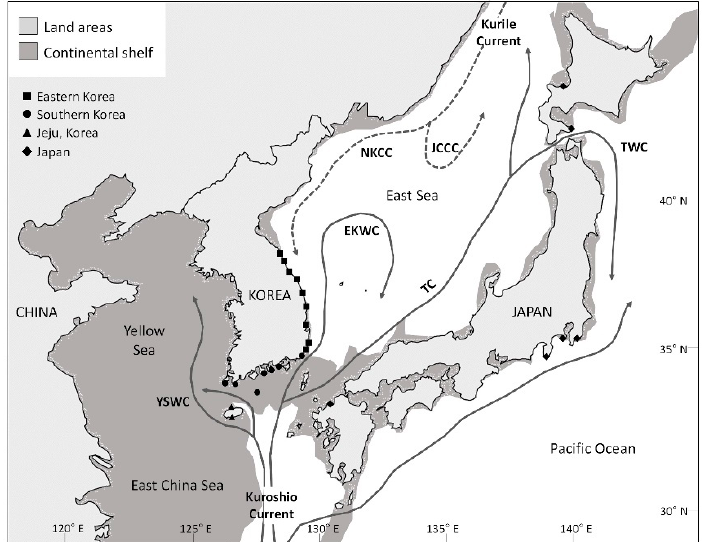
Figure 1. Map of the Korean Peninsula displaying the currents and collection sites of two Pachy- meniopsis species. Shaded areas indicate sea regions that would have been exposed during periods of sea level (~130 m). Dotted arrow lines indicate the cold currents, and solid arrow lines show the warm currents. YSWC, Yellow Sea Warm Current; EKWC, East Korea Warm Current; TC, Tsushima Current; TWC, Tsugaru Warm Current; NKCC, North Korea Cold Current; JCCC, Japan Central Cold Current.